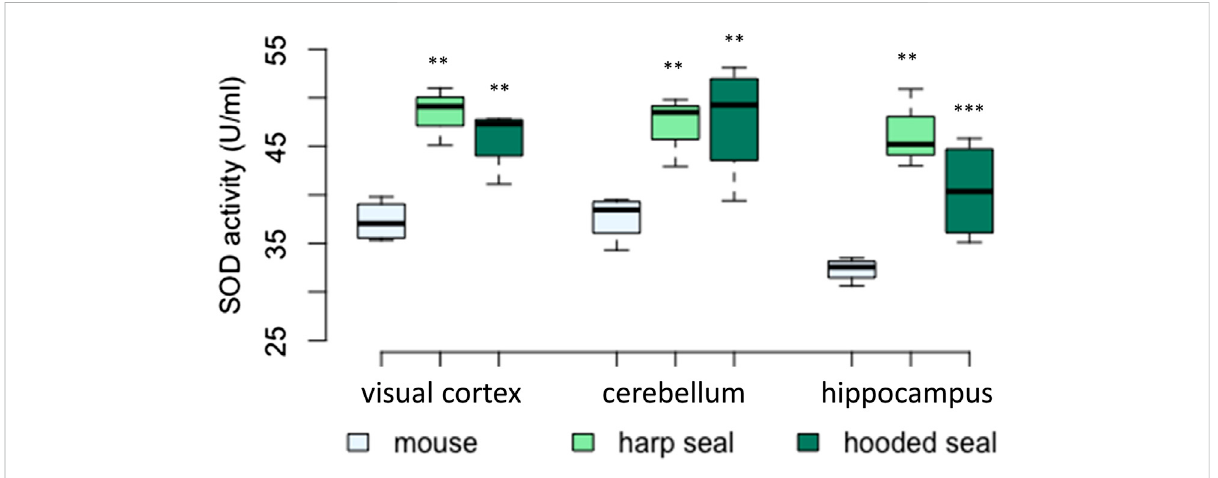
FIGURE 2 Superoxide dismutase (SOD) activity (U/ml) in mice, harp seals and hooded seals. Signi fi cance levels refer to differences compared to mice in the respective brain region and are represented by asterisks ( p ≤ 0.05 (*), p ≤ 0.01 (**), p ≤ 0.01